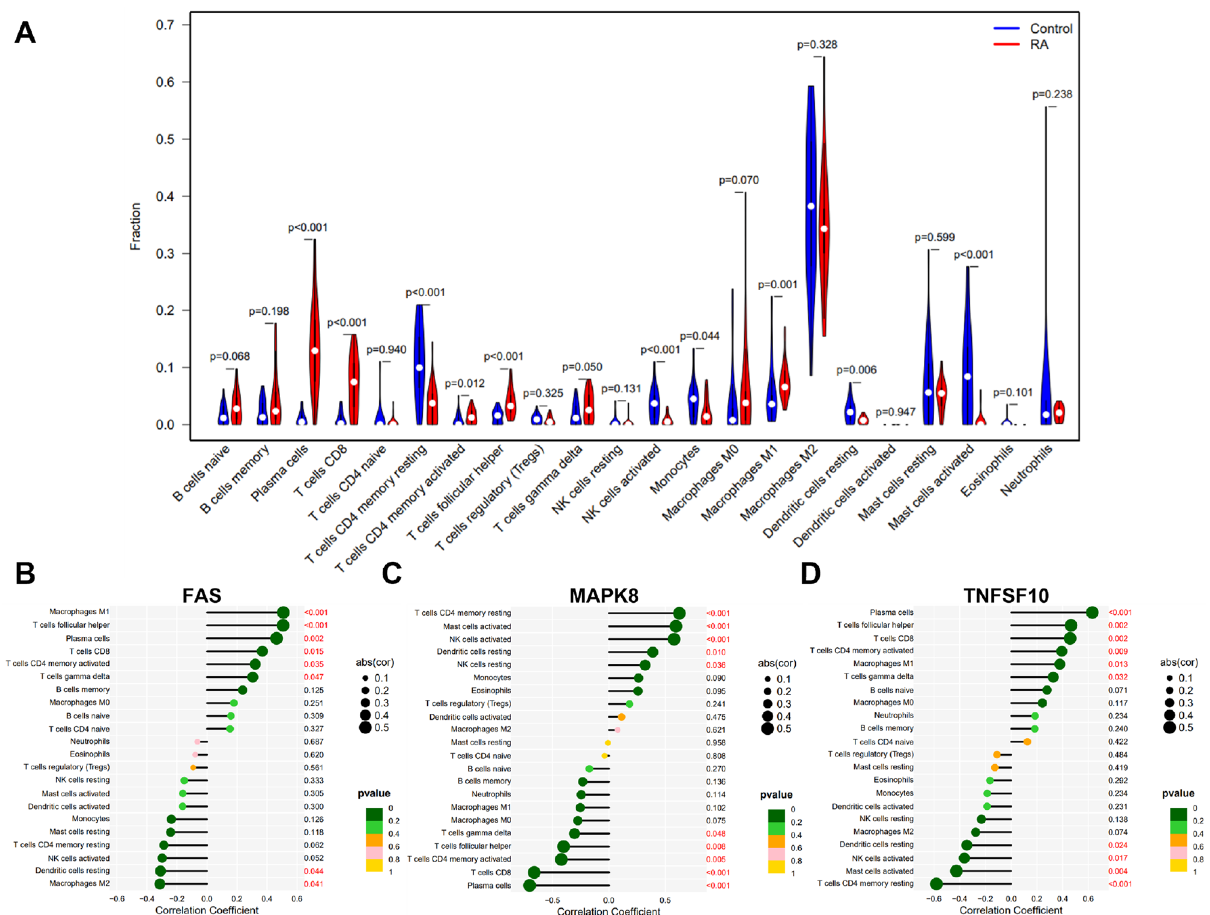
Figure 5. Immune cell infiltration analysis. ( A ) Implementation of the CIBERSORT algorithm to explore the differences in immune microenvironment between RA patients and normal samples. ( B ) Graph of key genes and immune cell correlation